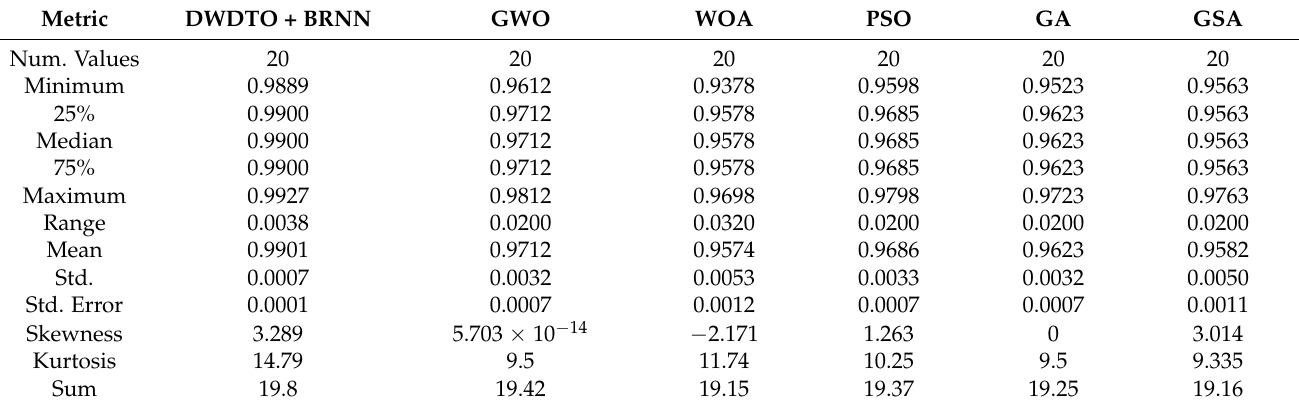
Table 6. Statistical analysis of the achieved results using the proposed DWDTO applied to the first dataset